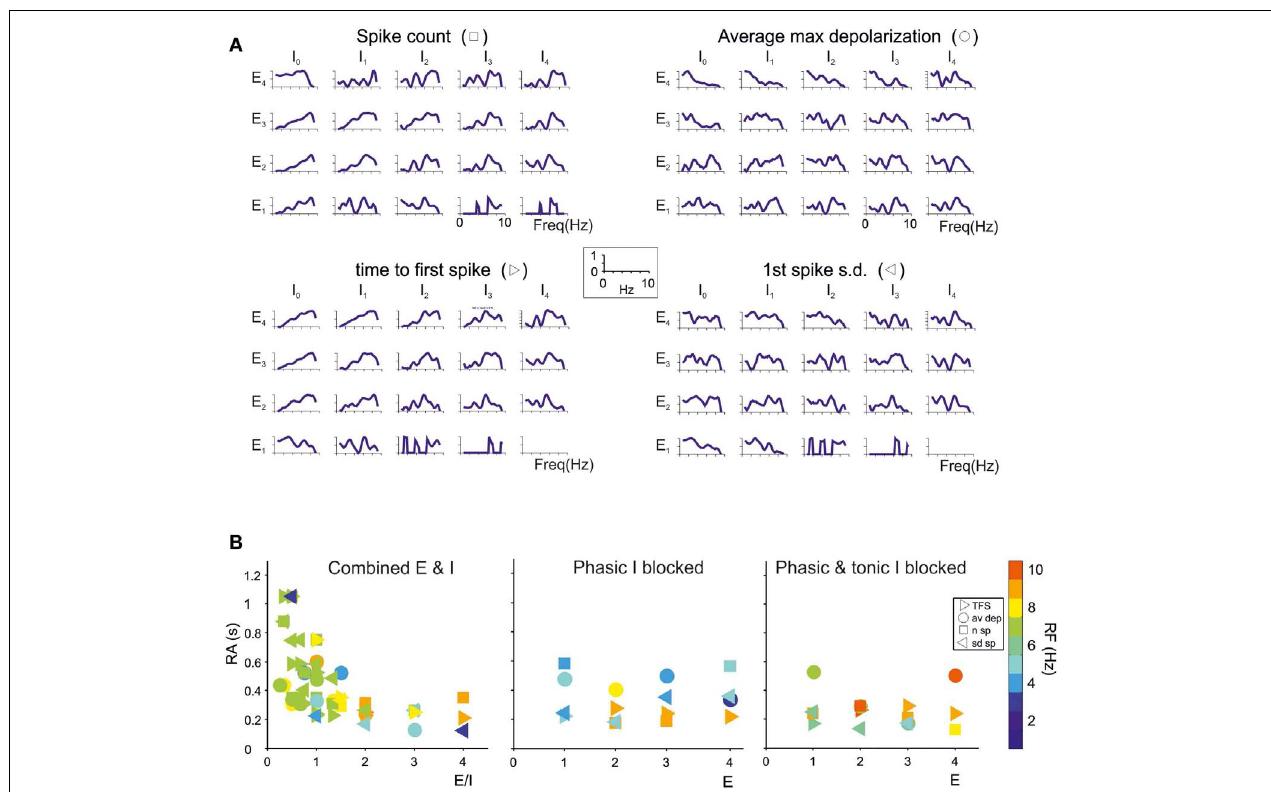
(defined in Materials and Methods) for individual parameters ( sc, ssd, sd, amd ) in the cases of coexistence of E and I (left), of phasic inhibition blocked (middle) or of both phasic and tonic inhibition blocked (right). For each point, RF is reported using a color code. Note that 5–7Hz RF clusters are at E / I ≤ 1 and correspond to the highest RA values, consistent with the enhancing effect of inhibition on resonance. Note also that, when both phasic and tonic inhibition are blocked, RF shifts toward higher values, as observed